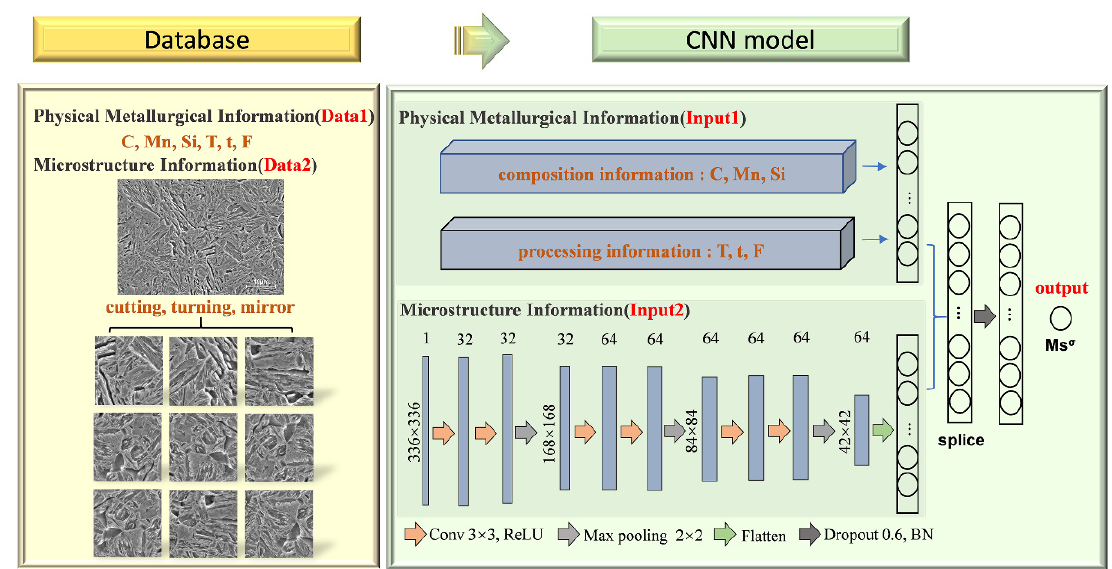
Figure 2. The framework of the proposed CNN model.